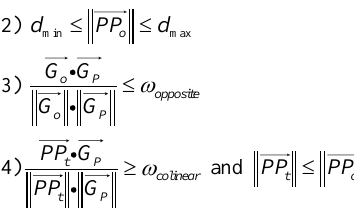
Point Cloud Segmentation: The proposed method segments the non-ground points into individual